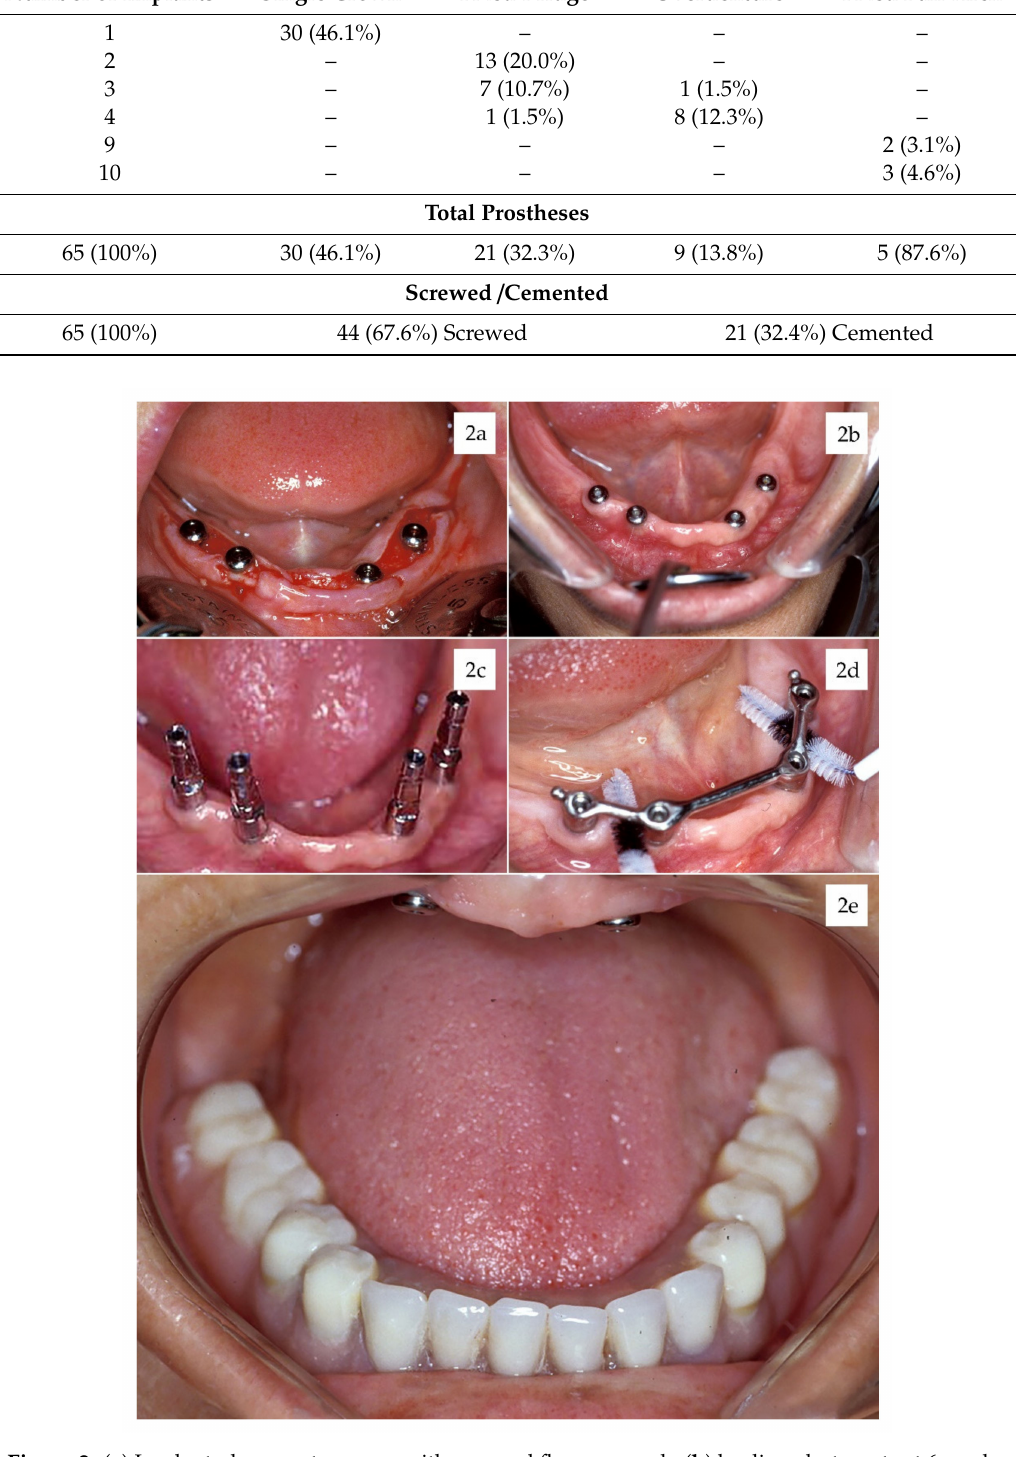
Figure 2. ( a ) Implant placement surgery with mucosal flap approach, ( b ) healing abutments at 6 weeks, ( c ) impression copings, ( d ) cleanable bar, and ( e ) finished overdenture. During the 17-year follow-up period, twenty-two patients (48.8%) showed complications. We had five early failures with the loss of 5 (2.96%) implants in three patients during the initial